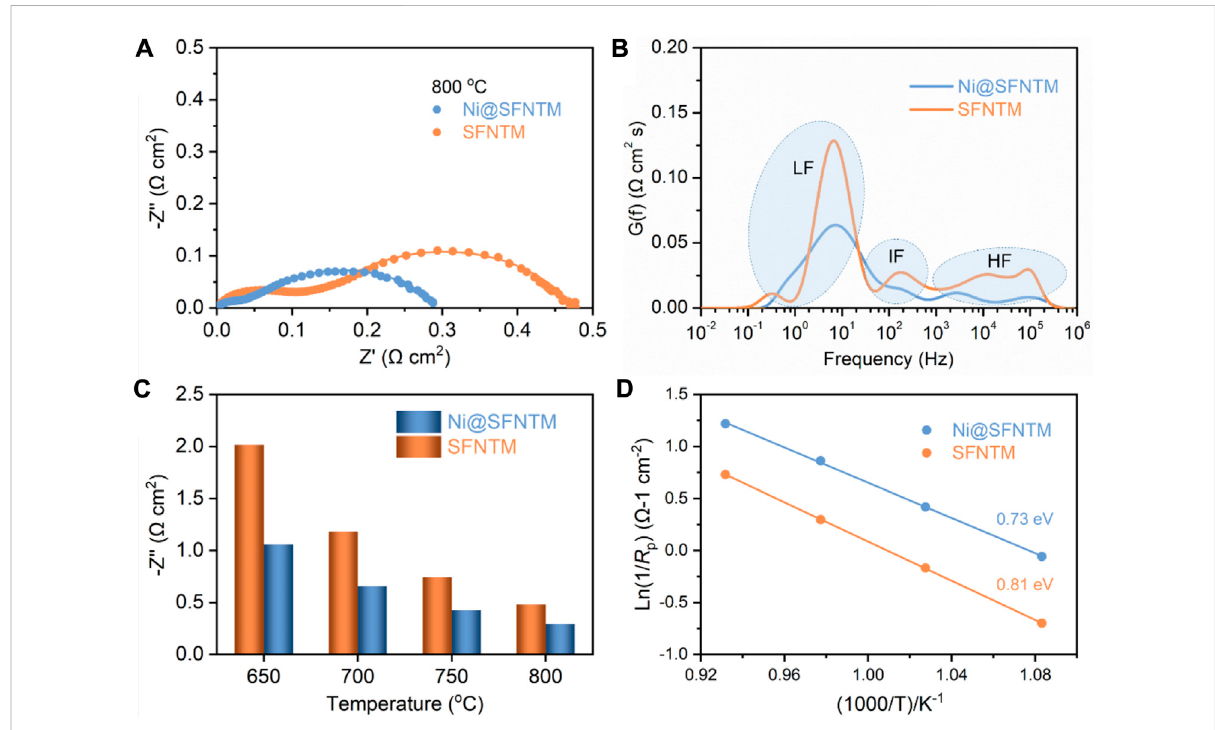
FIGURE 5 (A) EIS patterns of SFNTM and Ni@SFNTM powders at 800 ° C, and (B) corresponding distribution of the relaxation time (DRT) curves, (C) Impedance values of two samples from 650 to 800 ° C, (D) CO 2 -RR activation energy at 650 – 800 °